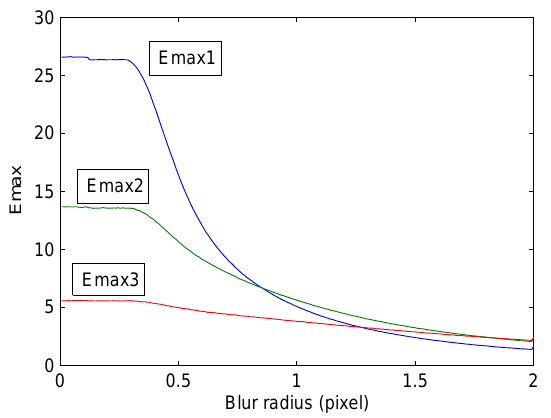
Figure 3: Ratios of ¯ E max values for white noise